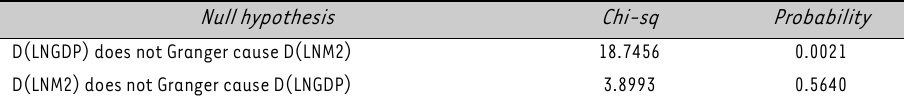
Granger causality test results between D (LNGDP) and D (LNM2) Null hypothesis Chi-sq Probability D(LNGDP) does not Granger cause D(LNM2) 18.7456 0.0021 D(LNM2) does not Granger cause D(LNGDP) 3.8993 0.5640